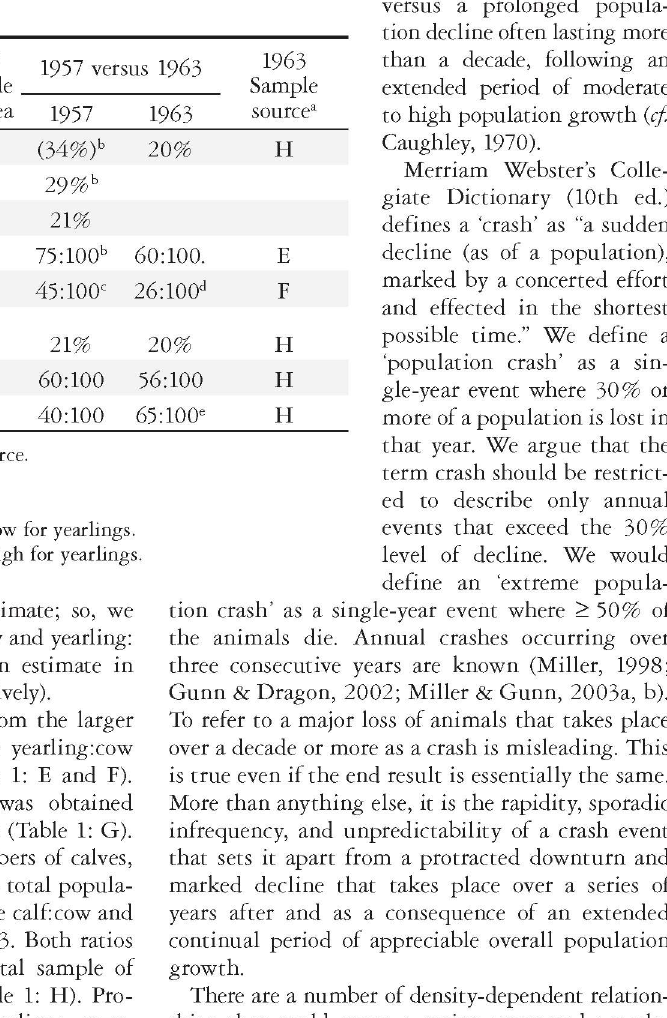
Table 2. Comparisons made for evaluating the 1957 and 1963 St. Matthew Island reindeer population parameters: see Table 1 for raw data from Klein (1959,